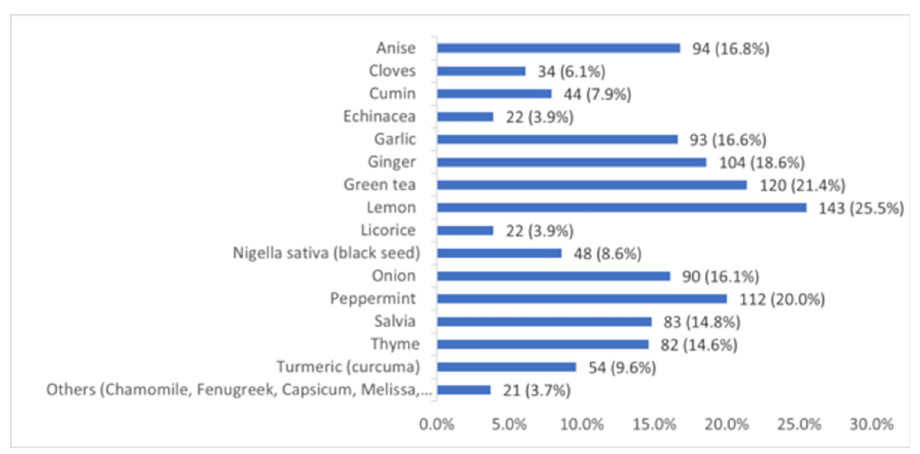
Fig 3. Types of herbal remedies used for COVID 19 prophylaxis (N = 141).